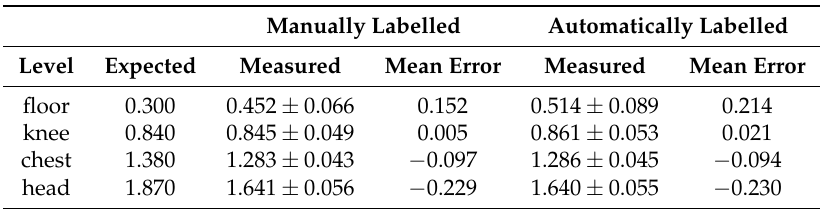
Table 5. The vertical height of the object was estimated for the beginning and ending of every lift. The error was calculated as the estimated height minus the reference height. The measured values and error are shown for each of the 4 possible vertical levels. All values shown are in meters.